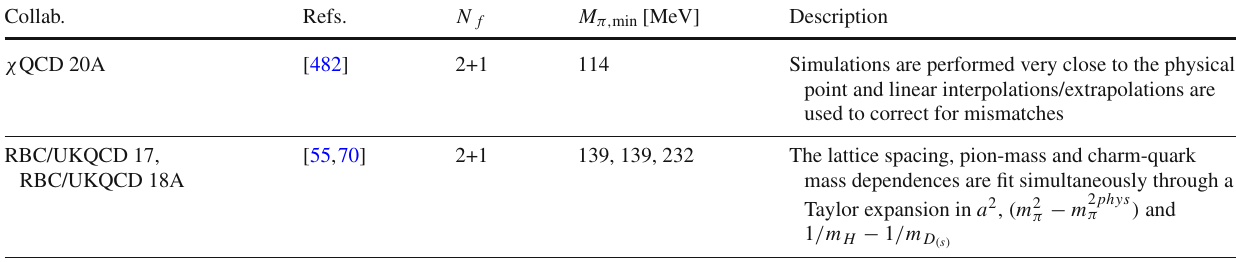
Table 125 Chiral extrapolation/minimum pion mass in N f = 2 + 1 determinations of the D - and D s -meson decay constants. For actions with multiple species of pions, masses quoted are the RMS pion masses. The different M π, min entries correspond to the different lattice spacings Collab.